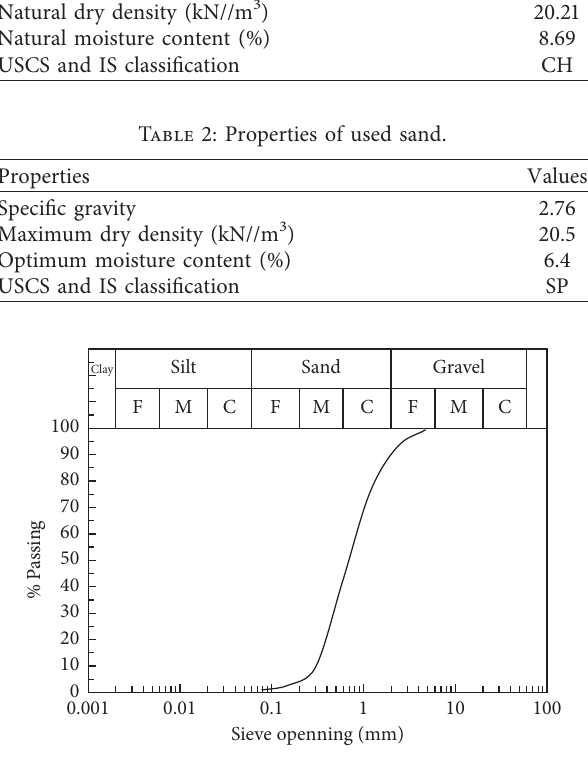
Figure 1: Particle size distribution curve for used sand.